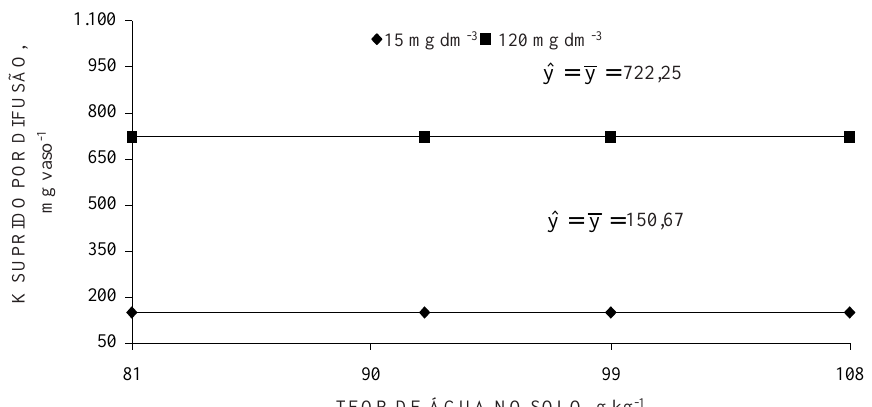
Figura 3. Quantidade de potássio suprida às raízes de milheto (28 DAE) por difusão, considerando os teores de água no solo, correspondentes aos potenciais testados, e a dose de potássio. Símbolos = valores observados; linha = valores estimados.